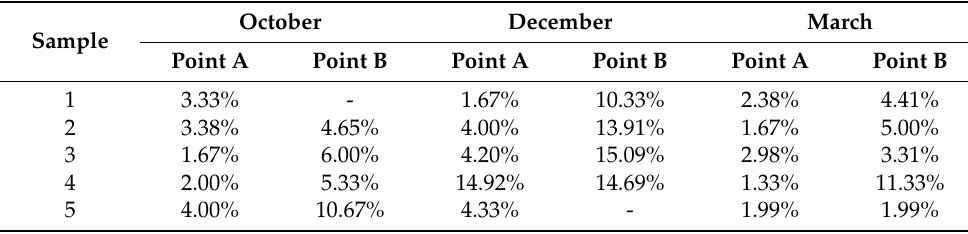
Table 3. Soil moisture content